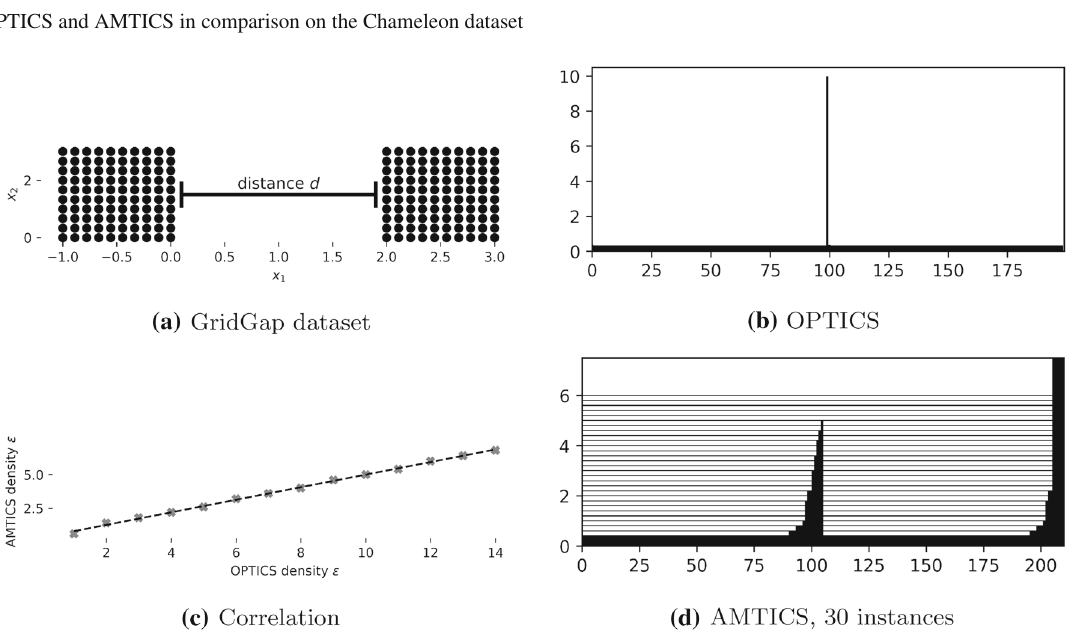
Fig. 10 Evaluation setup to estimate the correlation between density in OPTICS and density in AMTICS. Two regular point grids are divided into two clusters. The gap distance in between is increased incrementally. Comparison of two result plots of OPTICS and AMTICS on the GridGap dataset with d =